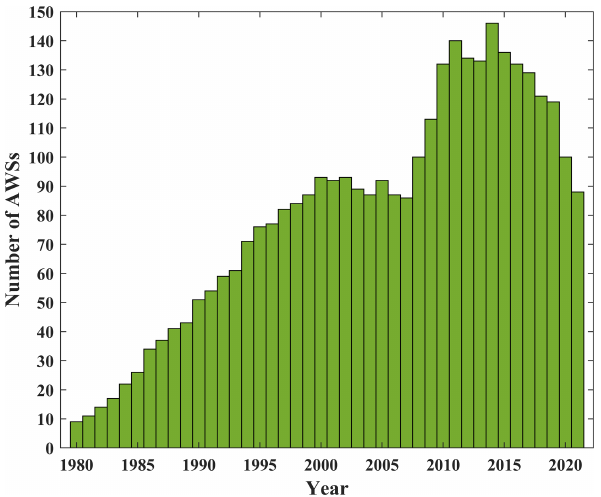
Figure 8. Number of AWSs counted each year.